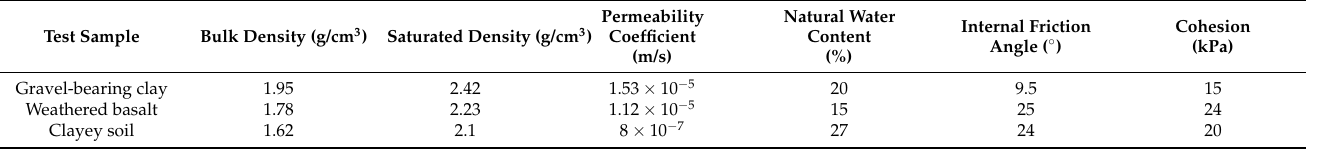
Table 1. Material properties of the test soil.